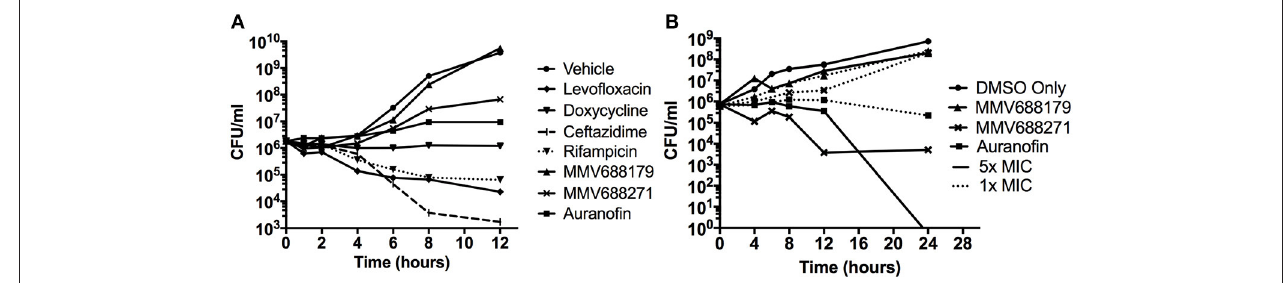
FIGURE 1 | Characterization of Novel Melioidosis Treatment Compounds. (A) B. pseudomallei was cultured with 1x MIC at 37 ◦ C for 12h. Over the course of time, CFUs were enumerated to determine if the compounds have a bacteriostatic or bactericidal activity. (B) B. pseudomallei was cultured with 1-5x MICs in the presence of 5% DMSO at 37 ◦ C for 24h. A vehicle control was included to show the effect of 5% DMSO on growth.